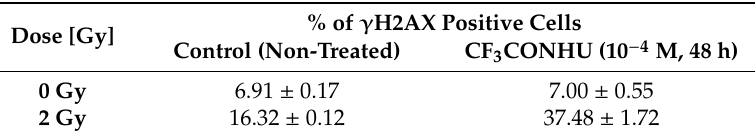
Table 1. Fractions of γ H2A.X positive cells 1 h after irradiation. Results are shown as mean ± standard deviation (SD) of two independent flow cytometry experiments.